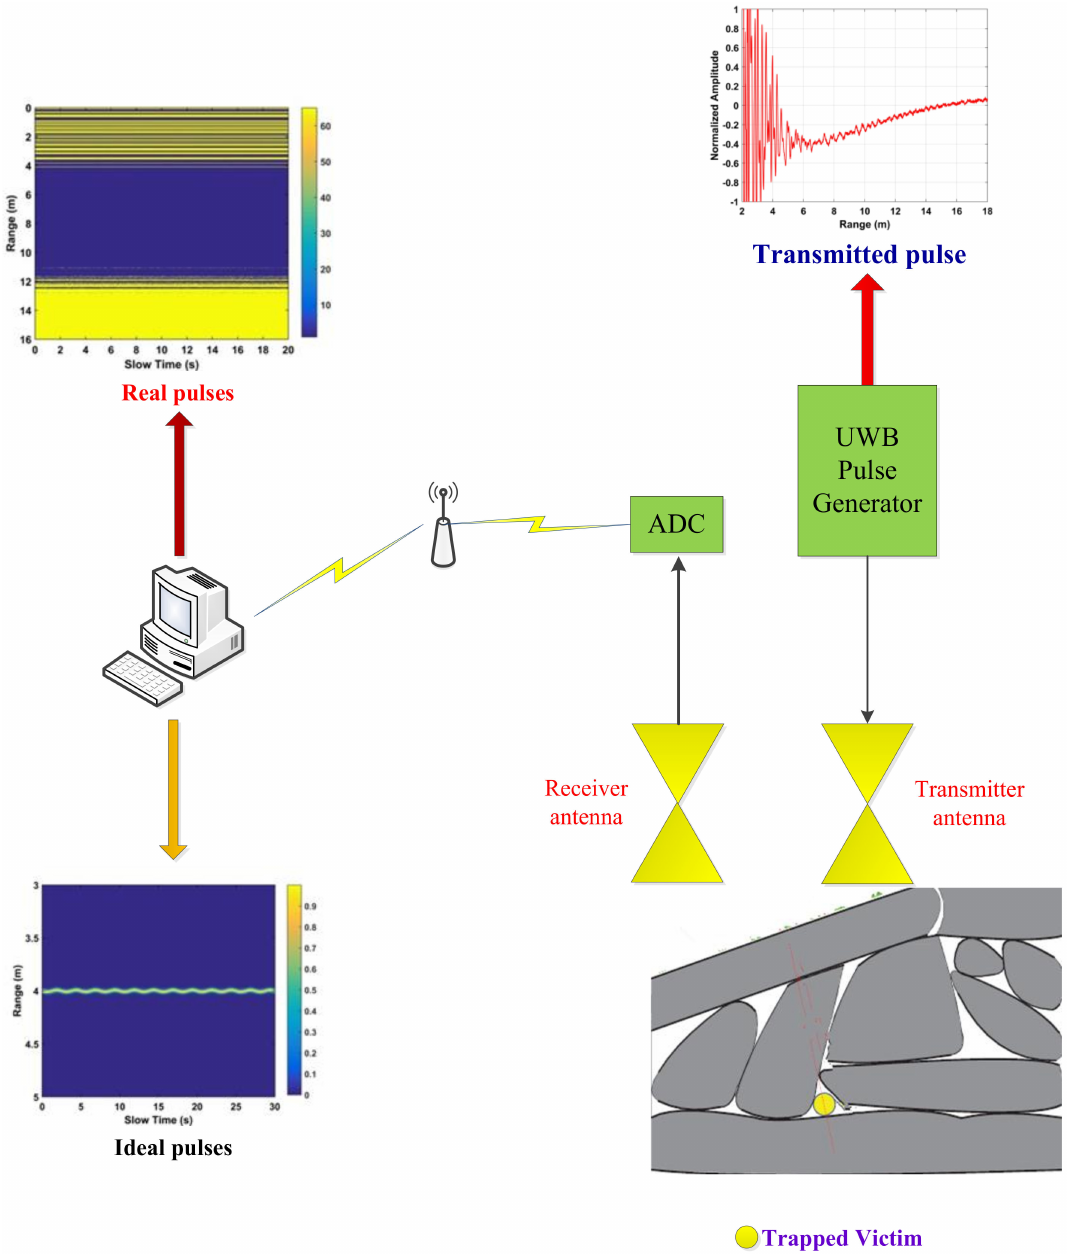
Figure 1. The model for vital sign detection using an UWB